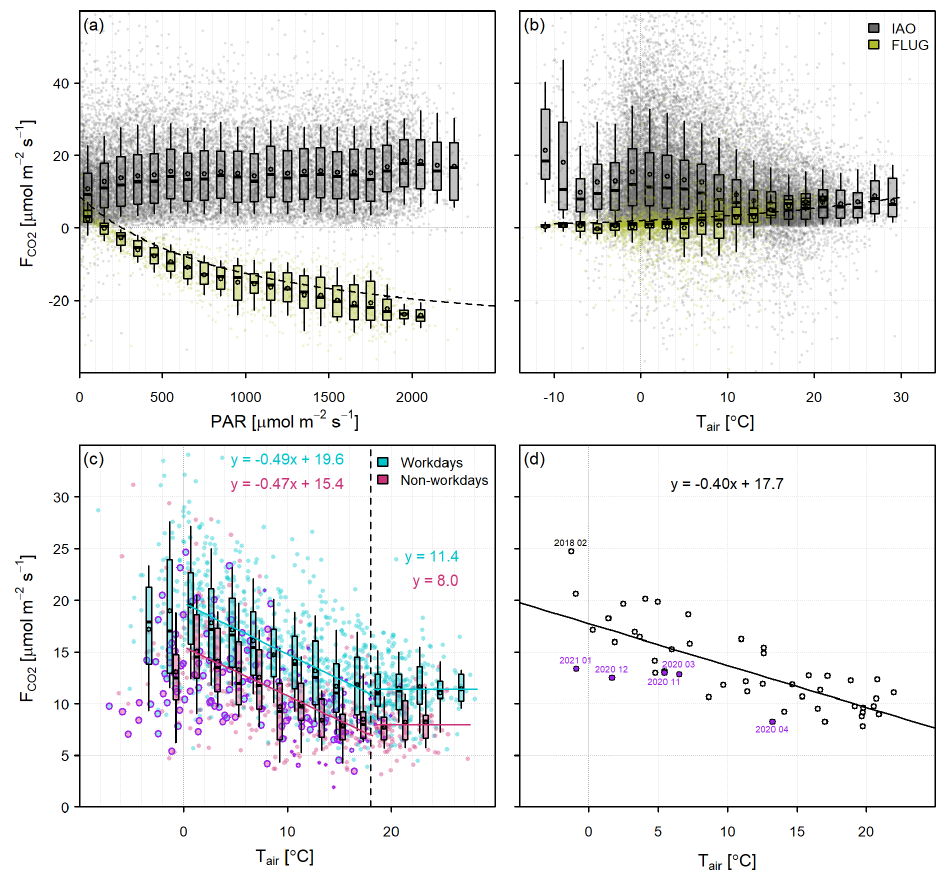
Figure 15. (a) The 30min daytime ( K ↓ > 5Wm − 2 ) observed CO 2 fluxes versus photosynthetically active radiation for all available data during the growing season (April–September, inclusive, but note that FLUG data are only available for 15 September 2017–22 May 2018), and (b) 30min nighttime ( K ↓ ≤ 5Wm − 2 ) observed CO 2 fluxes versus air temperature for the urban (IAO) and grassland (FLUG) sites. The dashed lines show (a) the light-response curve and (b) soil respiration rate for a grassland site in the nearby Stubai Valley (Wohlfahrt et al., 2005; Li et al., 2008). (c) Daily mean CO 2 flux versus daily mean air temperature separated into working and non-working days (daily values have been gap-filled using monthly median diurnal cycles for working and non-working days). Points outlined in purple occurred during COVID-19 restrictions. The vertical dashed line marks a base temperature of 18 ◦ C, above which F CO does not decrease with temperature. 2 (d) Average monthly observed CO 2 fluxes versus average monthly air temperature. Purple points indicate months with the strictest COVID- 19 restrictions. In panels (a) – (c) , boxes indicate the interquartile range, whiskers the 10th–90th percentile, horizontal bars the median and points the mean. In panels (c) – (d) , solid lines are linear regressions with the equations